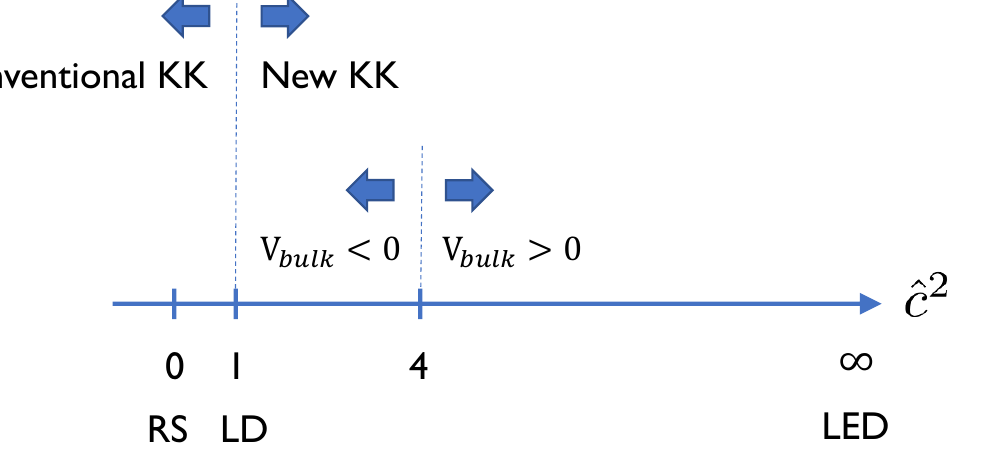
Figure 1 . Critical points of ^ c 2